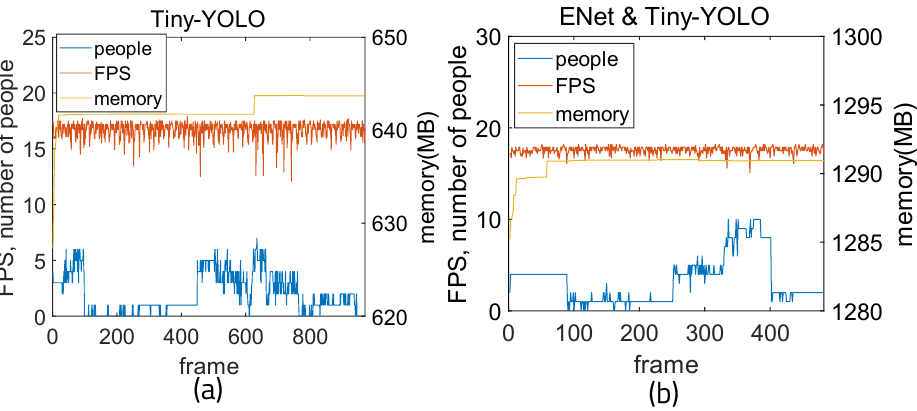
Figure 20. Time measurement results for Tiny-YOLO: ( a ) Tiny-YOLO and ( b ) ENet and